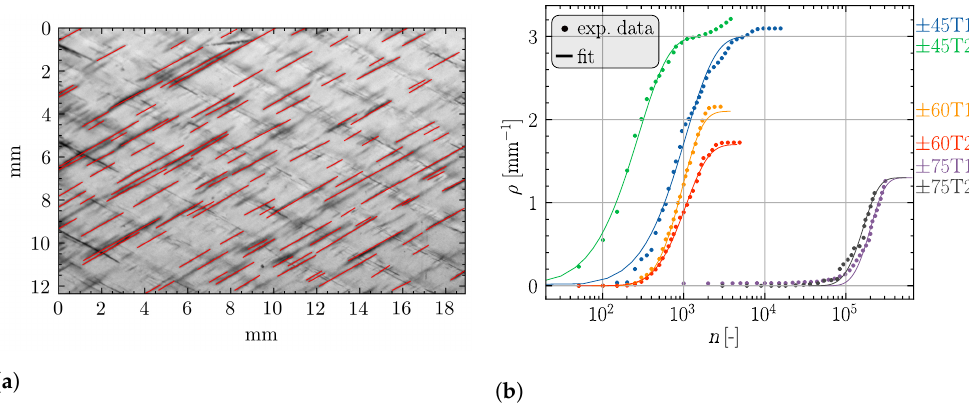
Figure 6. Results of the crack detection. An example of the detected cracks for ± 60° T1 is shown at 759 cycles ( a ). Cracks are only detected in the chosen direction of +60°. ( b ) shows the crack density results for all tests and the crack density